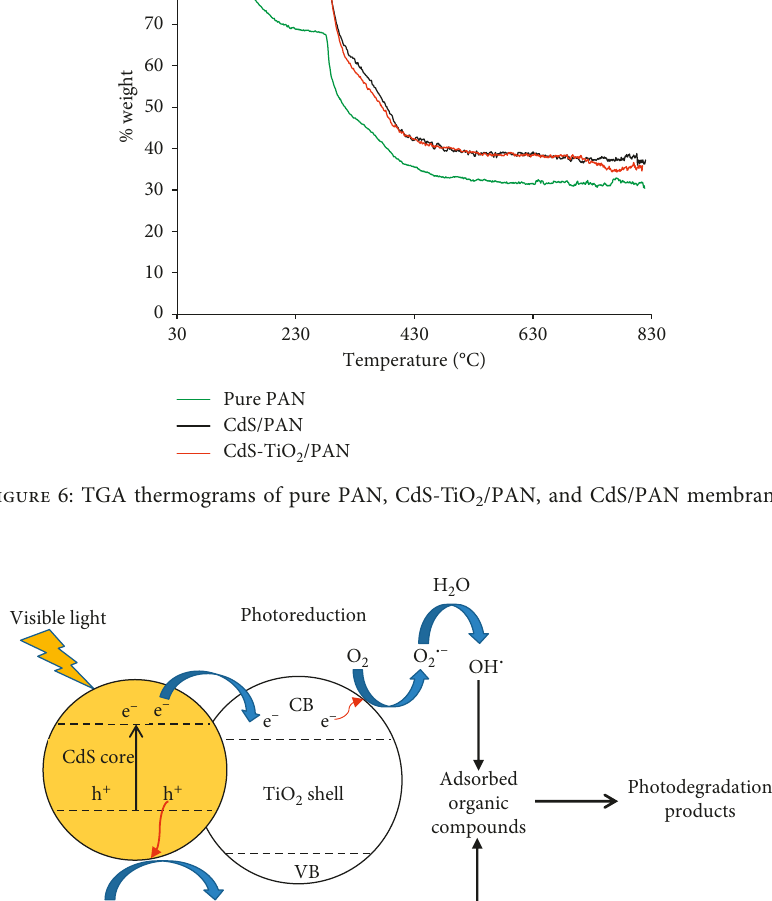
2 hybrid nanoparticle